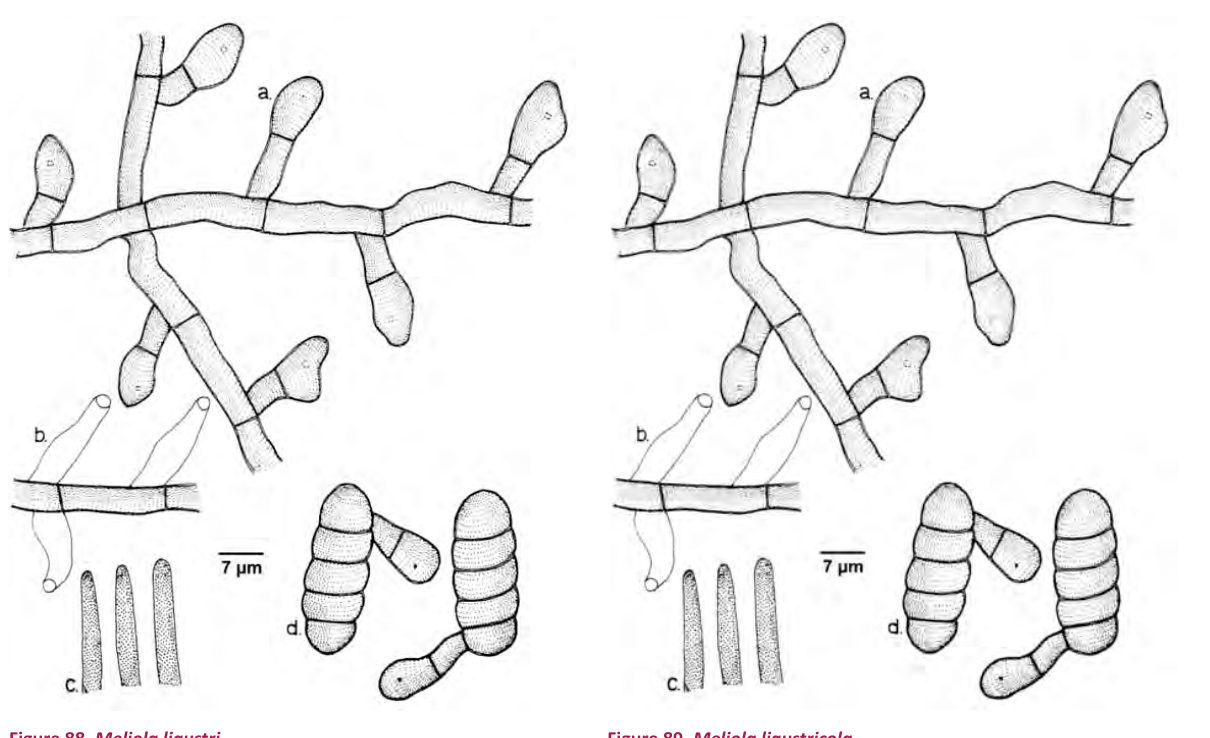
Figure 88. Meliola ligustri a - Appressorium; b - Phialide; c - Apical portion of mycelial setae;